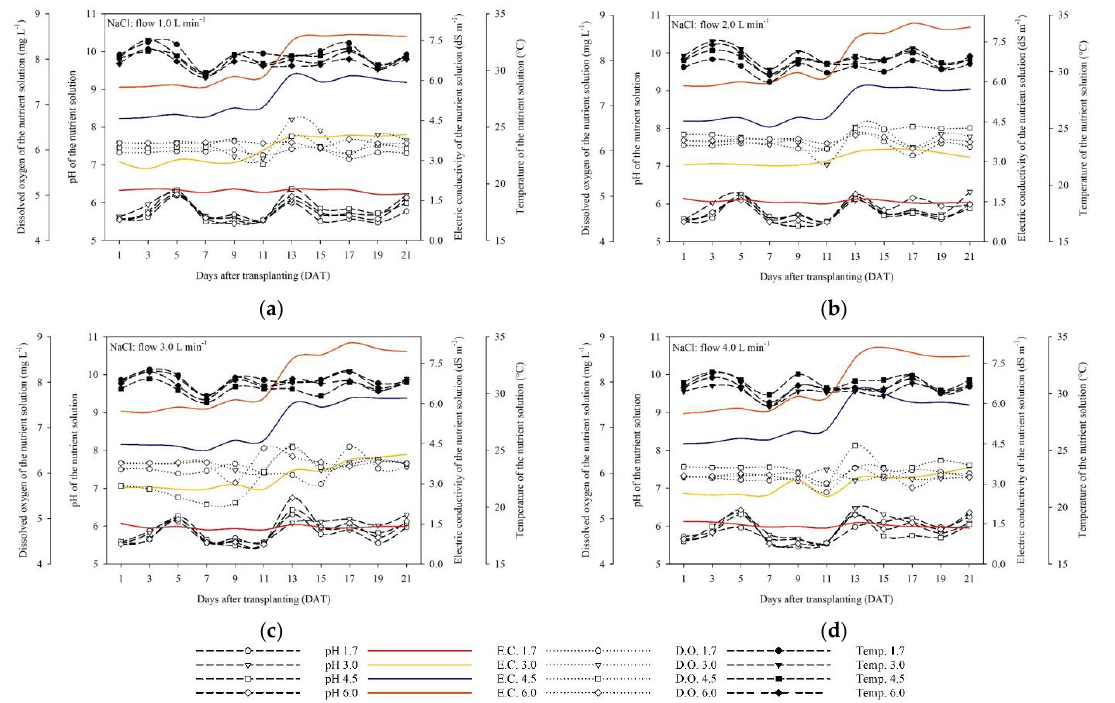
Figure 4. Values of electrical conductivity, pH, dissolved oxygen, and temperature of nutrient solu- tions that were prepared in brackish water with prevalence of NaCl and used in cultivation of cori- ander plants, cv. Verdão, applied in different flows (1.0 ( a ), 2.0 ( b ), 3.0 ( c ) and 4.0 ( d ) L min − 1 ). Likewise, in the second cycle, in water prepared with CaCl 2 .2H 2 O and the replace- ment of the nutrient solution, there was also a reduction of 21.25, 28.78, 18.36, and 15.74% within the ECns of 1.7 dS m −1 . In addition, there were increases of 35.13, 29.70, 14.73, and 38.97% within the ECns of 6.0 dS m −1 for the flows of 1.0, 2.0, 3.0, and 4.0 L min −1 , respec- tively. This occurred when the initial and final ECns values were compared (Figure 5a – d).